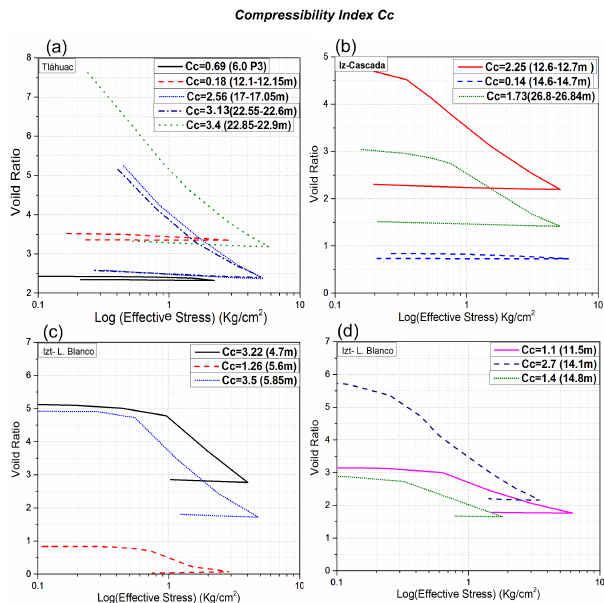
Figure 3. Compressibility plots of samples from the three borehole samples. (a) Five normally consolidated samples from 6 to 22.9m depth in the Tlahuac site, only the material in the surface is over consolidated and have the smaller Cc value and the deeper sam- ples have the higher Cc values; (b) three over consolidated samples from 12.6 to 26.8m depth in La Cascada site, the lowest Cc value is placed at 14m depth and the highest at 12m depth; ( c and d ) six over consolidated samples from 4.7 to 14.8m depth in the Lucio Blanco site, the lower Cc value corresponds to a 11.5m depth sam- ple and the higher at 5.85m depth. Note also high variations in Cc for the same depth (e.g. at 12m depth: 0.18, 2.25, and 1.1) for the different